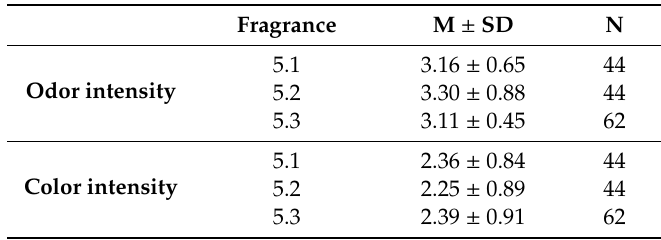
Table 6. Characterization of the preferred fragrances concerning the intensity of the odor and the